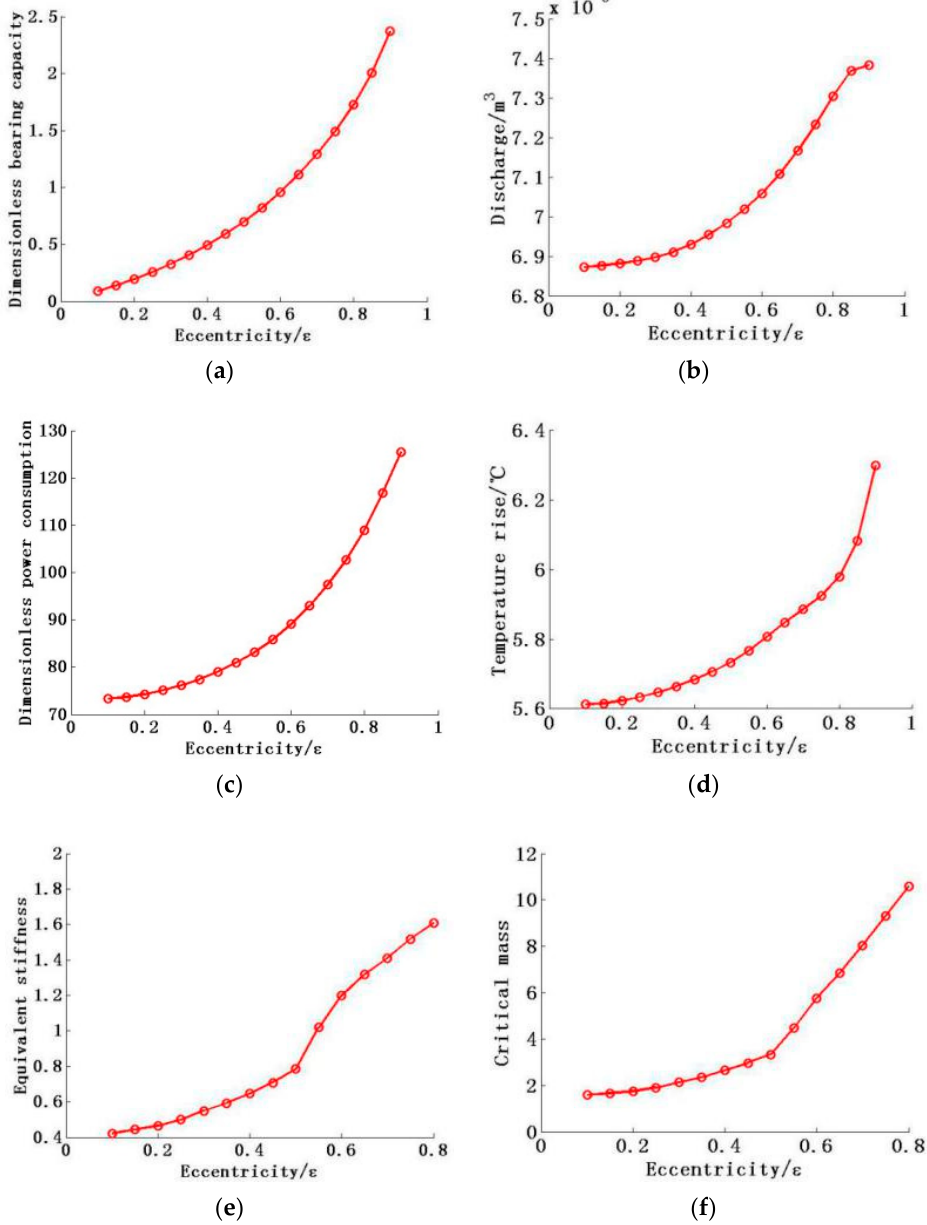
Figure 10. Curve of the performance parameters of V-g B with eccentricity: ( a ) Dimensionless bearing capacity; ( b ) Discharge; ( c ) Dimensionless power consumption; ( d ) Temperature rise; ( e ) Dimensionless equivalent stiffness; ( f ) Dimensionless critical mass.